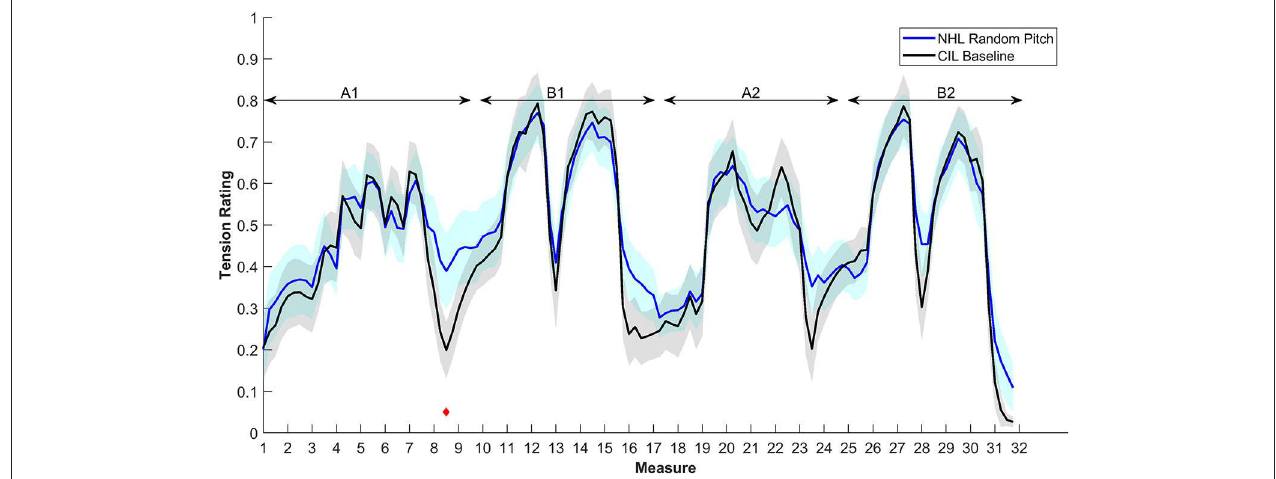
FIGURE 6 | Average tension ratings of 9 NHL for condition 2, random pitch (in blue), and 8 CIL for the baseline (in black). See details in Figure 1 .